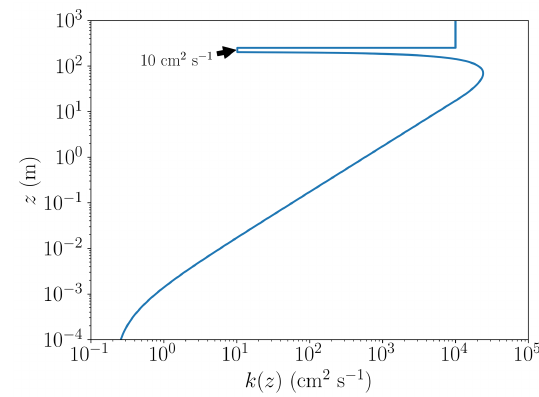
Figure 1. The turbulent diffusion coefficient k(z) as a function of altitude z for a boundary layer height of 200m, a wind speed of 5ms − 1 , k f = 1m 2 s − 1 , and the inversion layer thickness of